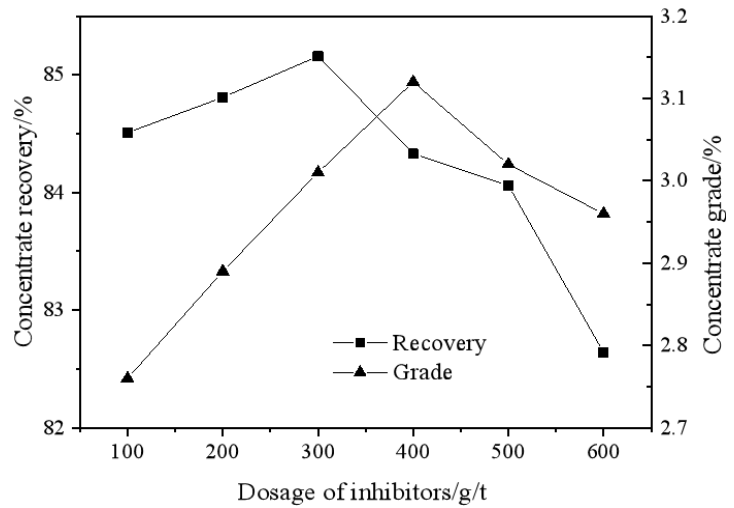
Figure 9. Influences of the inhibitor dosages of the copper oxide flotation index.